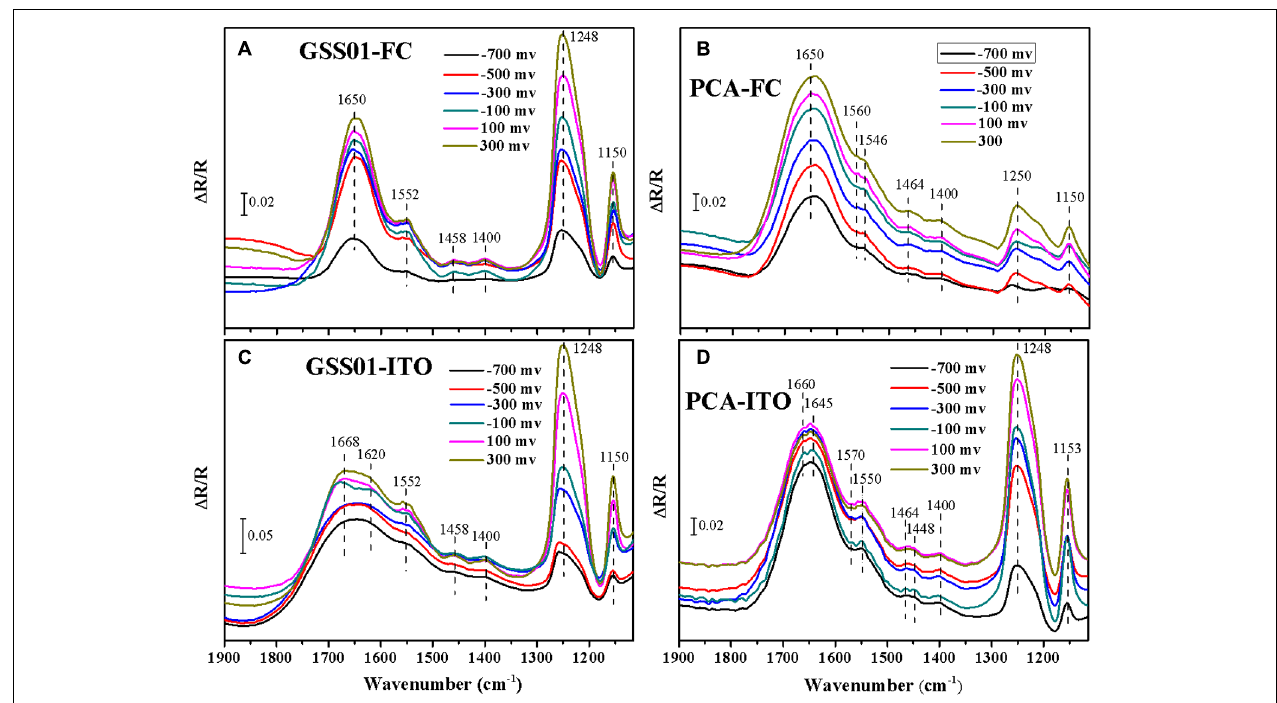
FIGURE 3 | Electrochemical in situ FTIR spectra of G. soli GSS01 (A,C) and G. sulfurreducens PCA (B,D) grown with FC (a,b) and ITO (C,D) . Results are representative of three